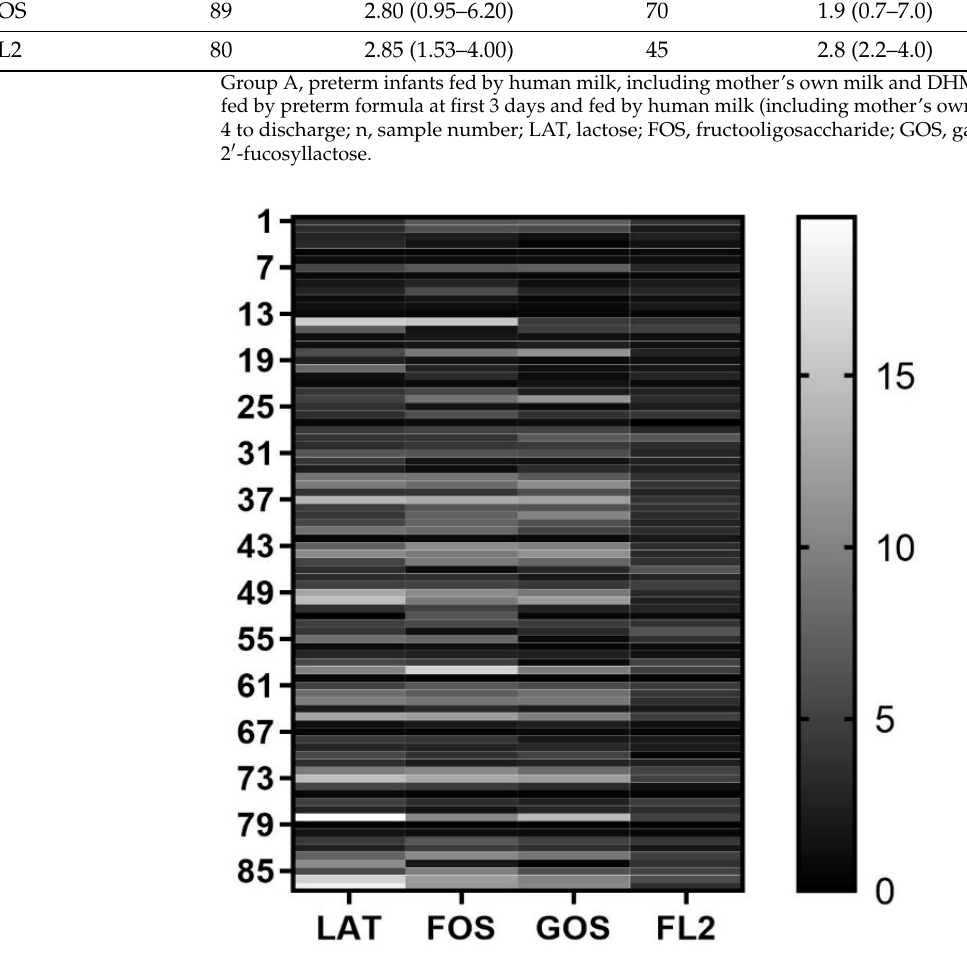
Table 3. Gas production in different media by in vitro fermentation modeling system.